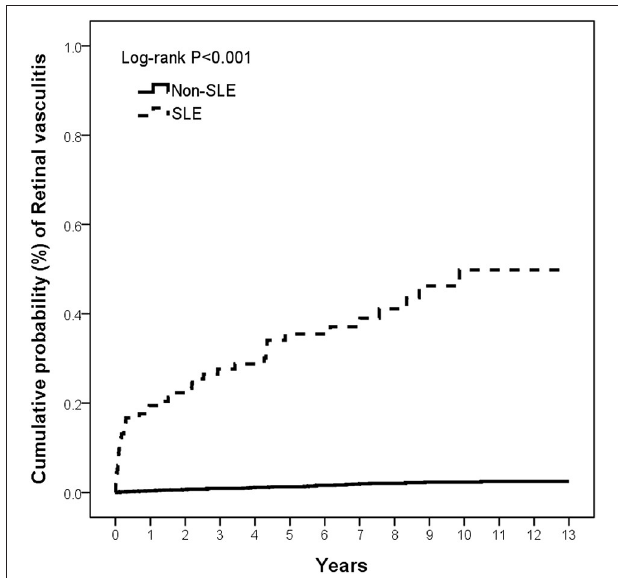
FIGURE 2 | The cumulative incidence of retinal vasculitis in patients with and without SLE. SLE, systemic lupus erythematosus. TABLE 2 | Incidence of retinal vasculitis in the SLE and non-SLE groups. 1:20 age–sex matching Non-SLE